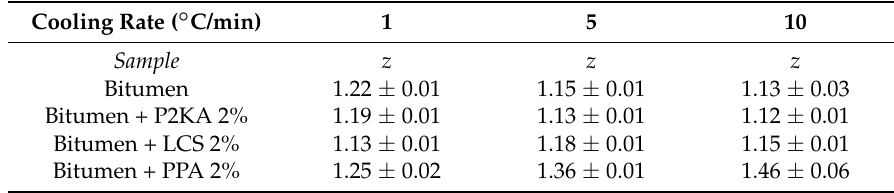
Table 2. Dependence of the coordination number z on the cooling rate, calculated as a fitting parameter in Equation (1) adapted to experimental oscillatory rheological data, |G*| vs. frequency, for neat bitumen and bitumens modified with